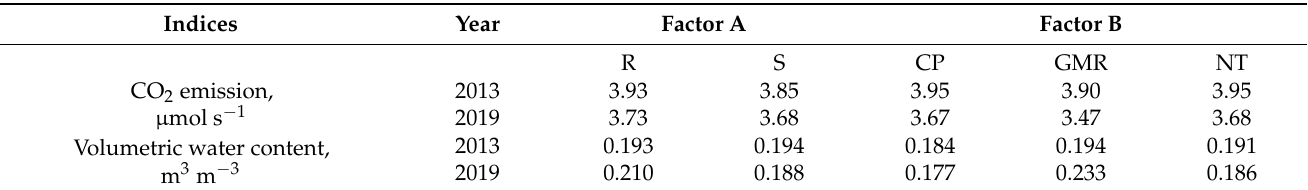
Table 2. The influence of tillage intensity and straw retention on CO 2 emissions from the soil surface (0–10 cm) and volumetric water content available to